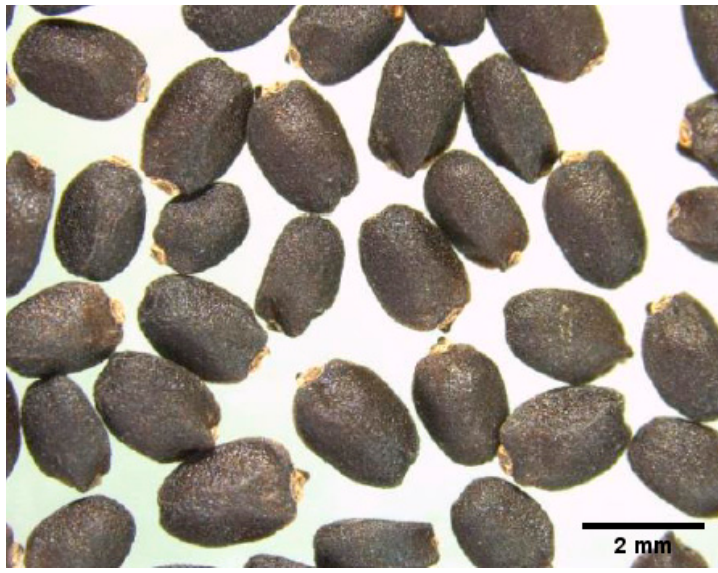
Figure 1. Basil seeds. Considering that seeds from different geographic locations have different character- istics, it would be interesting in future studies to include seeds from Latin and North American countries, mainly due to the differences in environmental conditions.